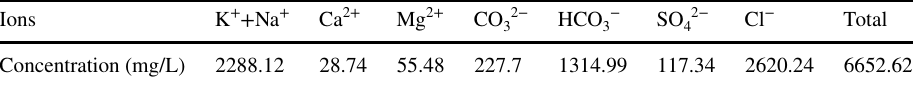
Table 1 Ion composition of formation brine in N